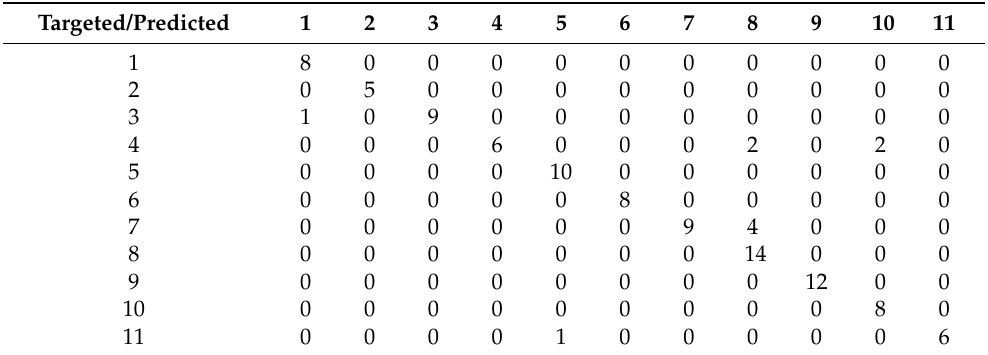
Table 6. The confusion matrix for 3D Resnet152 [21]. Targeted/Predicted